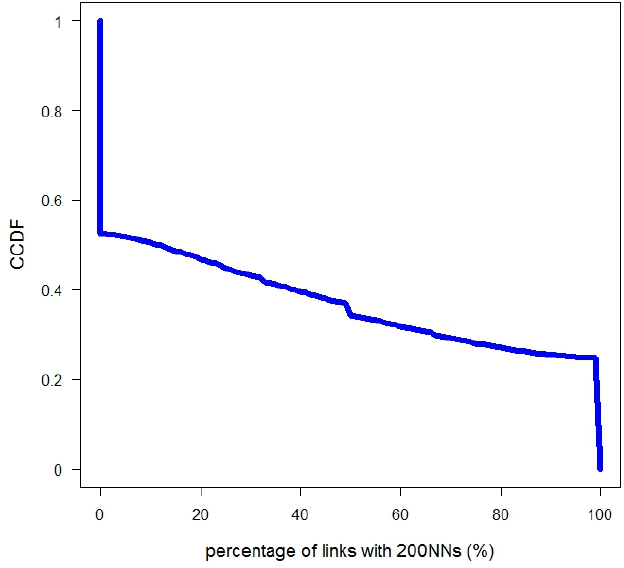
Figure 2. Complementary cumulative distribution function (CCDF) of percentage of links a venue has with K NNs.